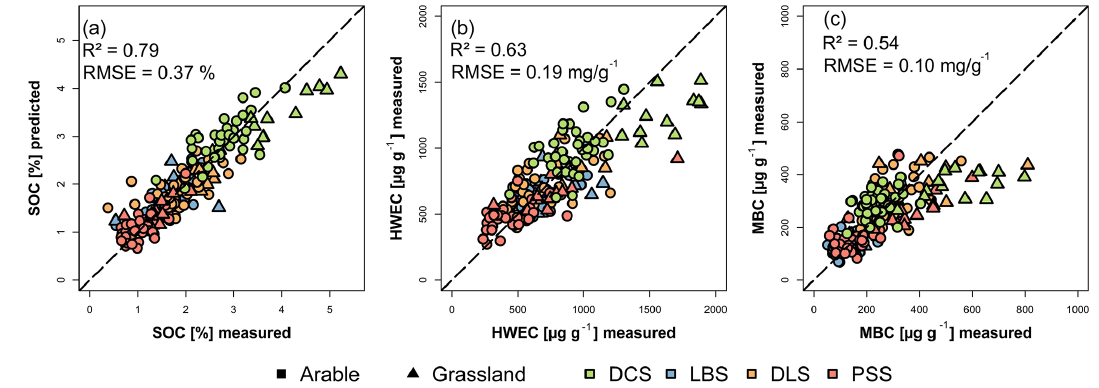
Figure 3. Predicted vs. measured content of SOC (a) , HWEC (b) , and MBC (c) for the global (complete) dataset based on mixed-effect models. Parent materials are Devonian clay schist (DCS), sandy dolomitic limestone (DLS), Luxembourg sandstone (LBS), and Permian siltstone and fine sandstone (PSS). RMSE is given in % for SOC and in mgg − 1 for HWEC and